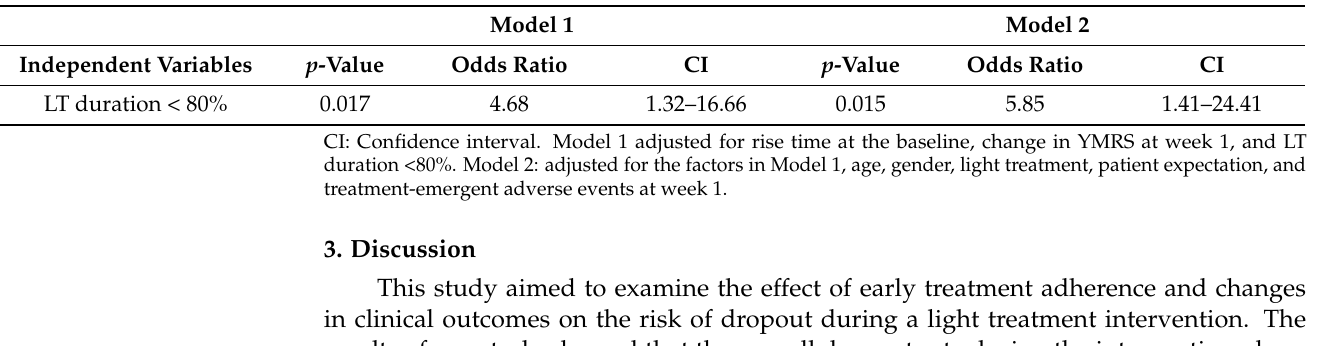
Table 4. Logistic regression analysis for the predictors of